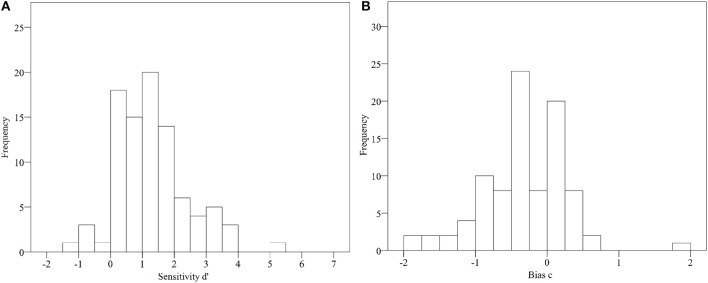
(A,B) Histogram of sensitivity d' (left) and response bias c (right) for the sample of music teachers (y-axis indicates frequencies).